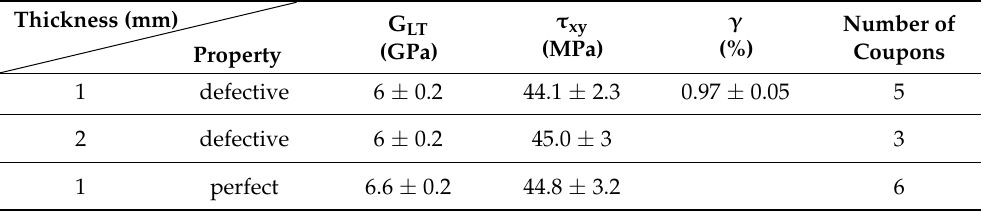
Figure 25. Radius profile and the angle notch for the shear coupon machined in ( a ) mechanical (arrow mark the defect) and ( b ) water cutting. Table 9. Shear values for different radius profile and thickness. Thickness (mm) Property